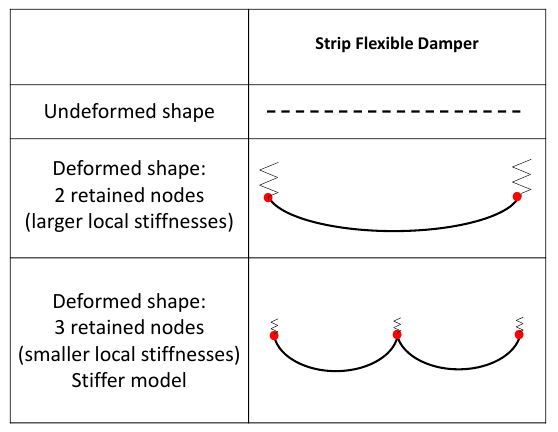
Figure 9. Effects of retained nodes on the model